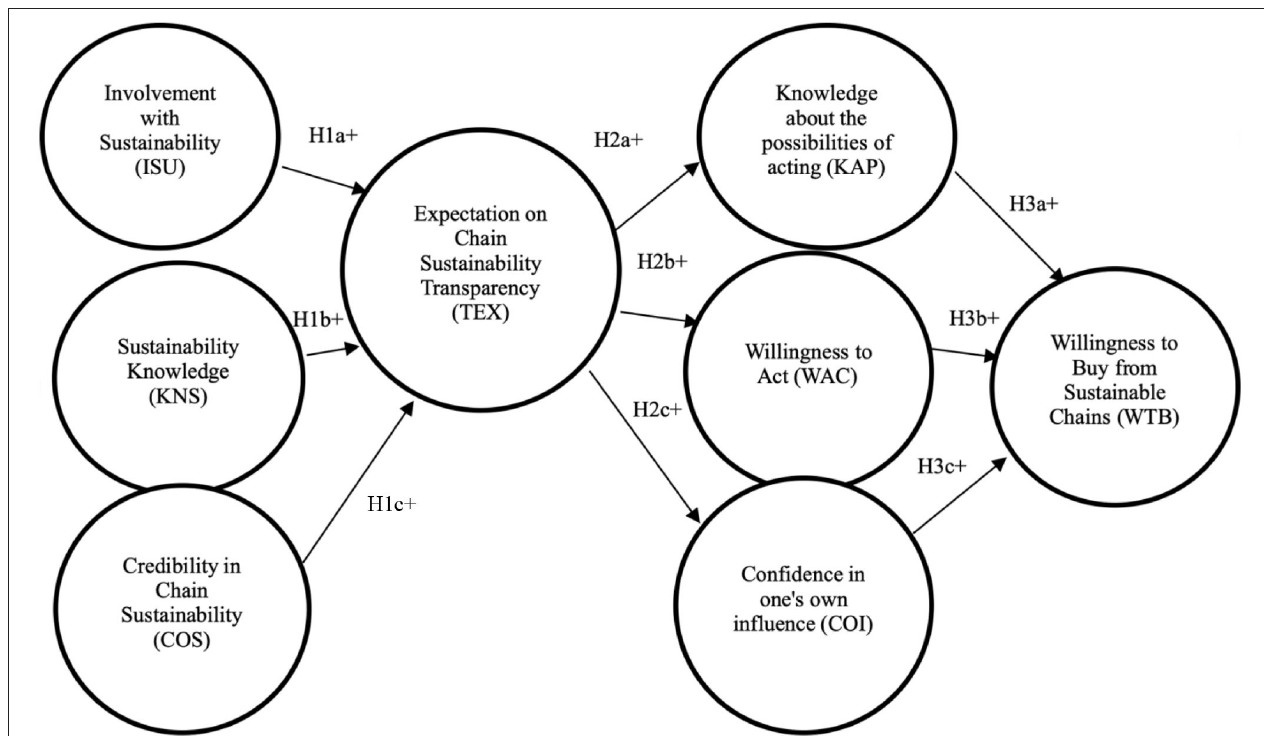
FIGURE 1 | Proposed analytical